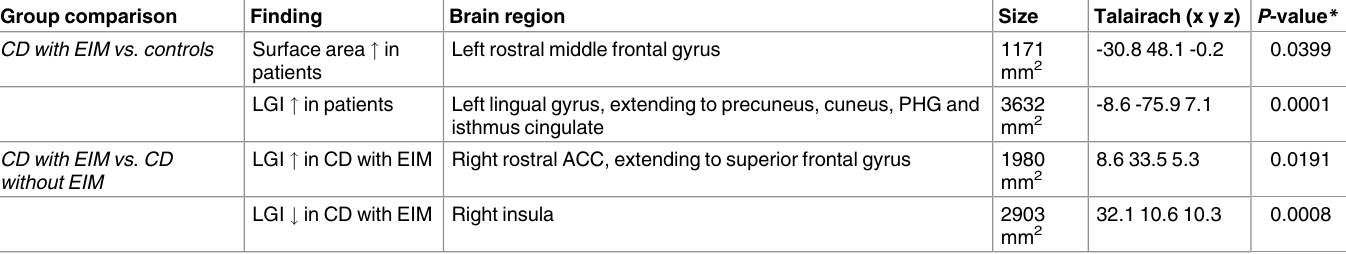
Table 2. Brain regions with significant group differences, corrected for multiple